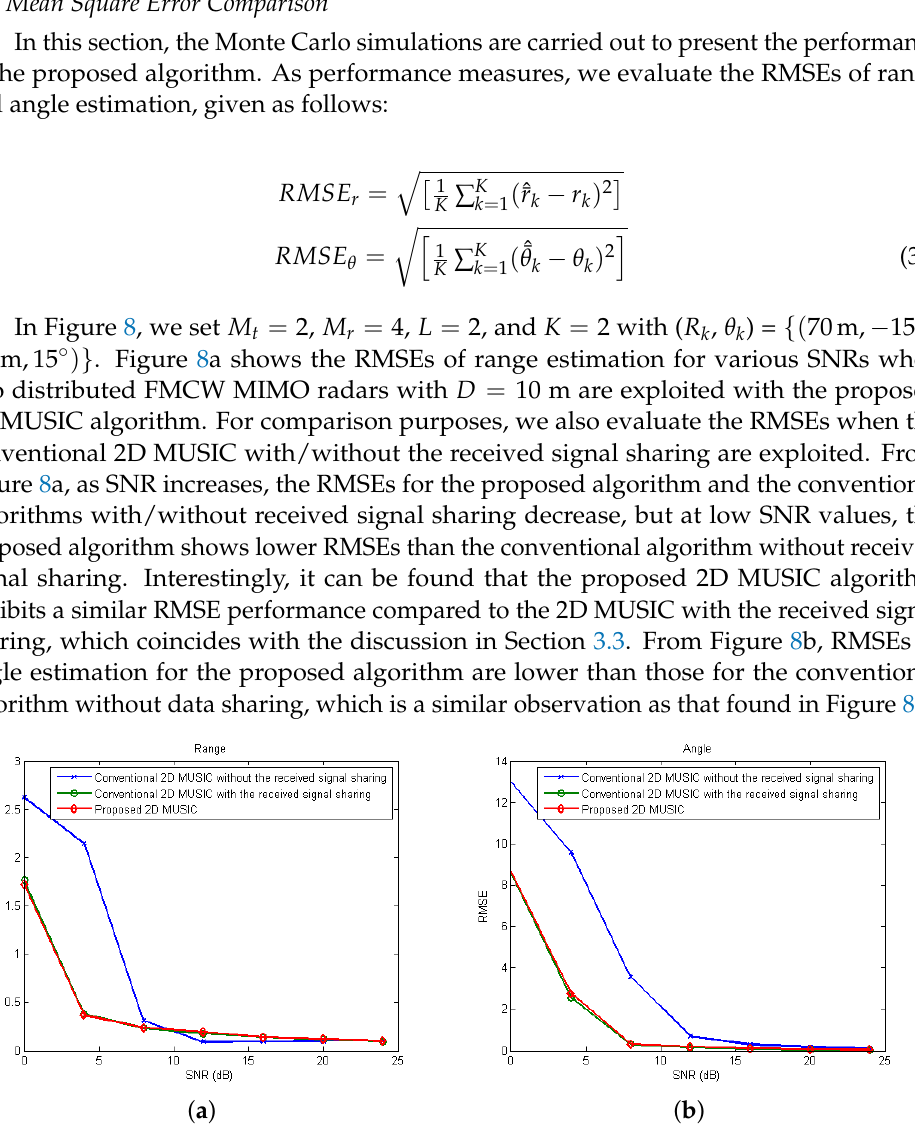
Figure 8. RMSE values of ( a ) range estimation and ( b ) angle estimation over various